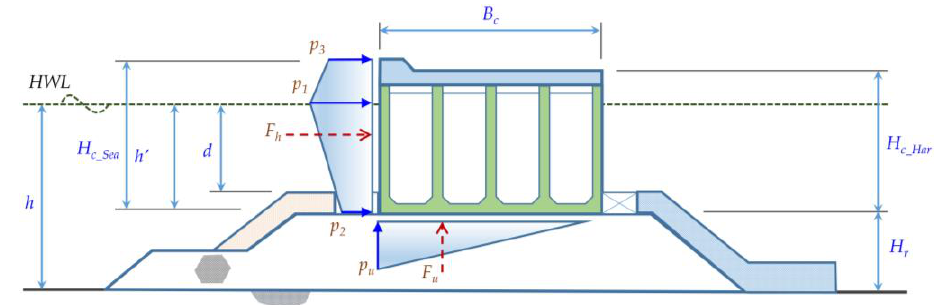
Figure 2. Locations of breakwaters considered in this study.